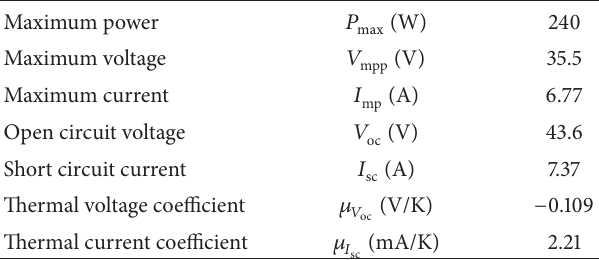
Table 3: Thermoelectrical features of the Sanyo HIT-240